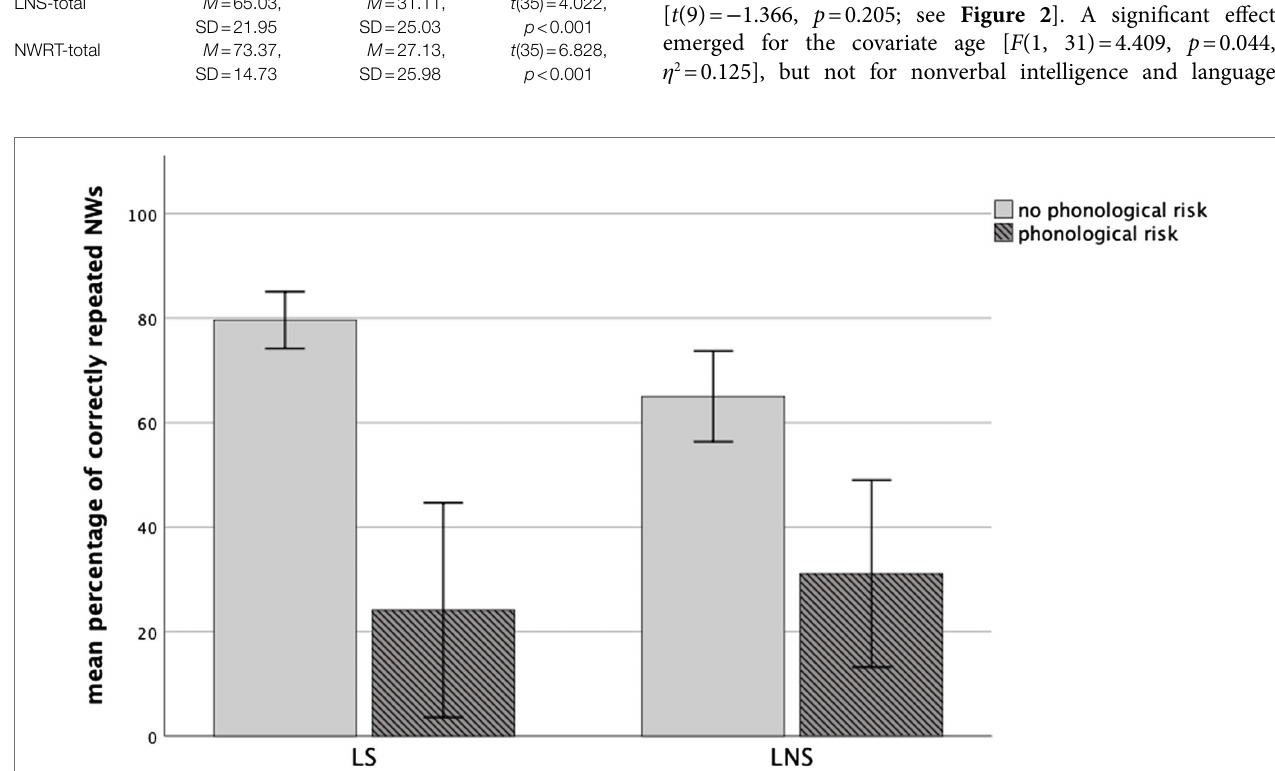
FIGURE 2 | Children’s mean percentage of correctly repeated LS vs. LNS NWs in the MuLiMi NWRT according to their phonological risk. Error bars represent 1 SD. No phonological risk: n = 27; phonological risk: n =